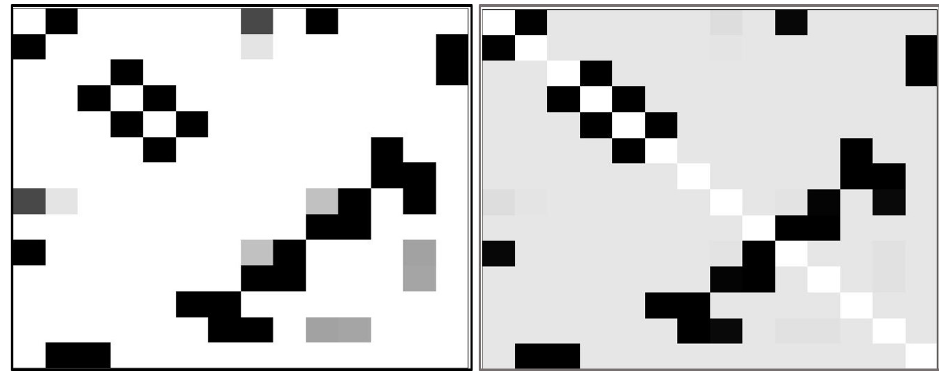
Figure 3. Pheromone trails before (on the left ) and after (on the right ) of pheromone